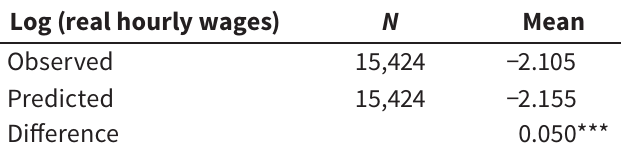
Differences in actual and predicted real wages for metropolitan out-migrants using hedonic prices as a denominator, after matching Log (real hourly wages) N Mean Observed 15,424 −2.105 Predicted 15,424 −2.155 Difference 0.050*** Significance levels *10% **5% ***1% for t -test of difference in means between observed and predicted wages. Predicted wages are based on a matched sample of metropolitan